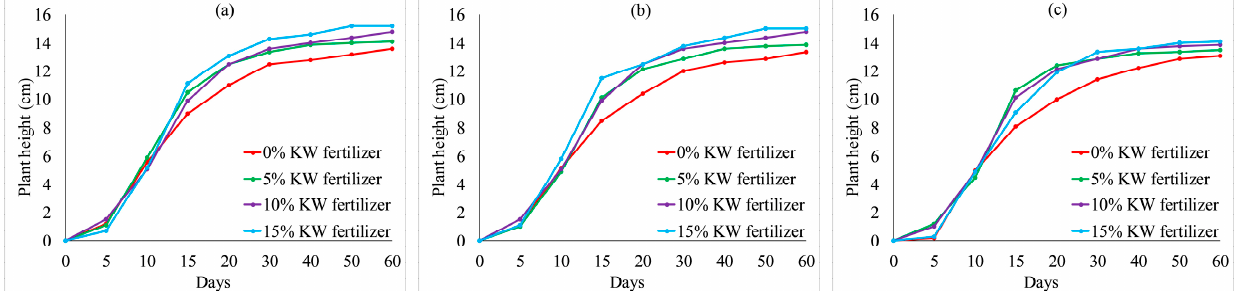
Figure 8. Ryegrass height relative to KW fertilizer content with different percentages of cement: ( a ) 4% cement; ( b ) 8% cement; ( c ) 12% cement.